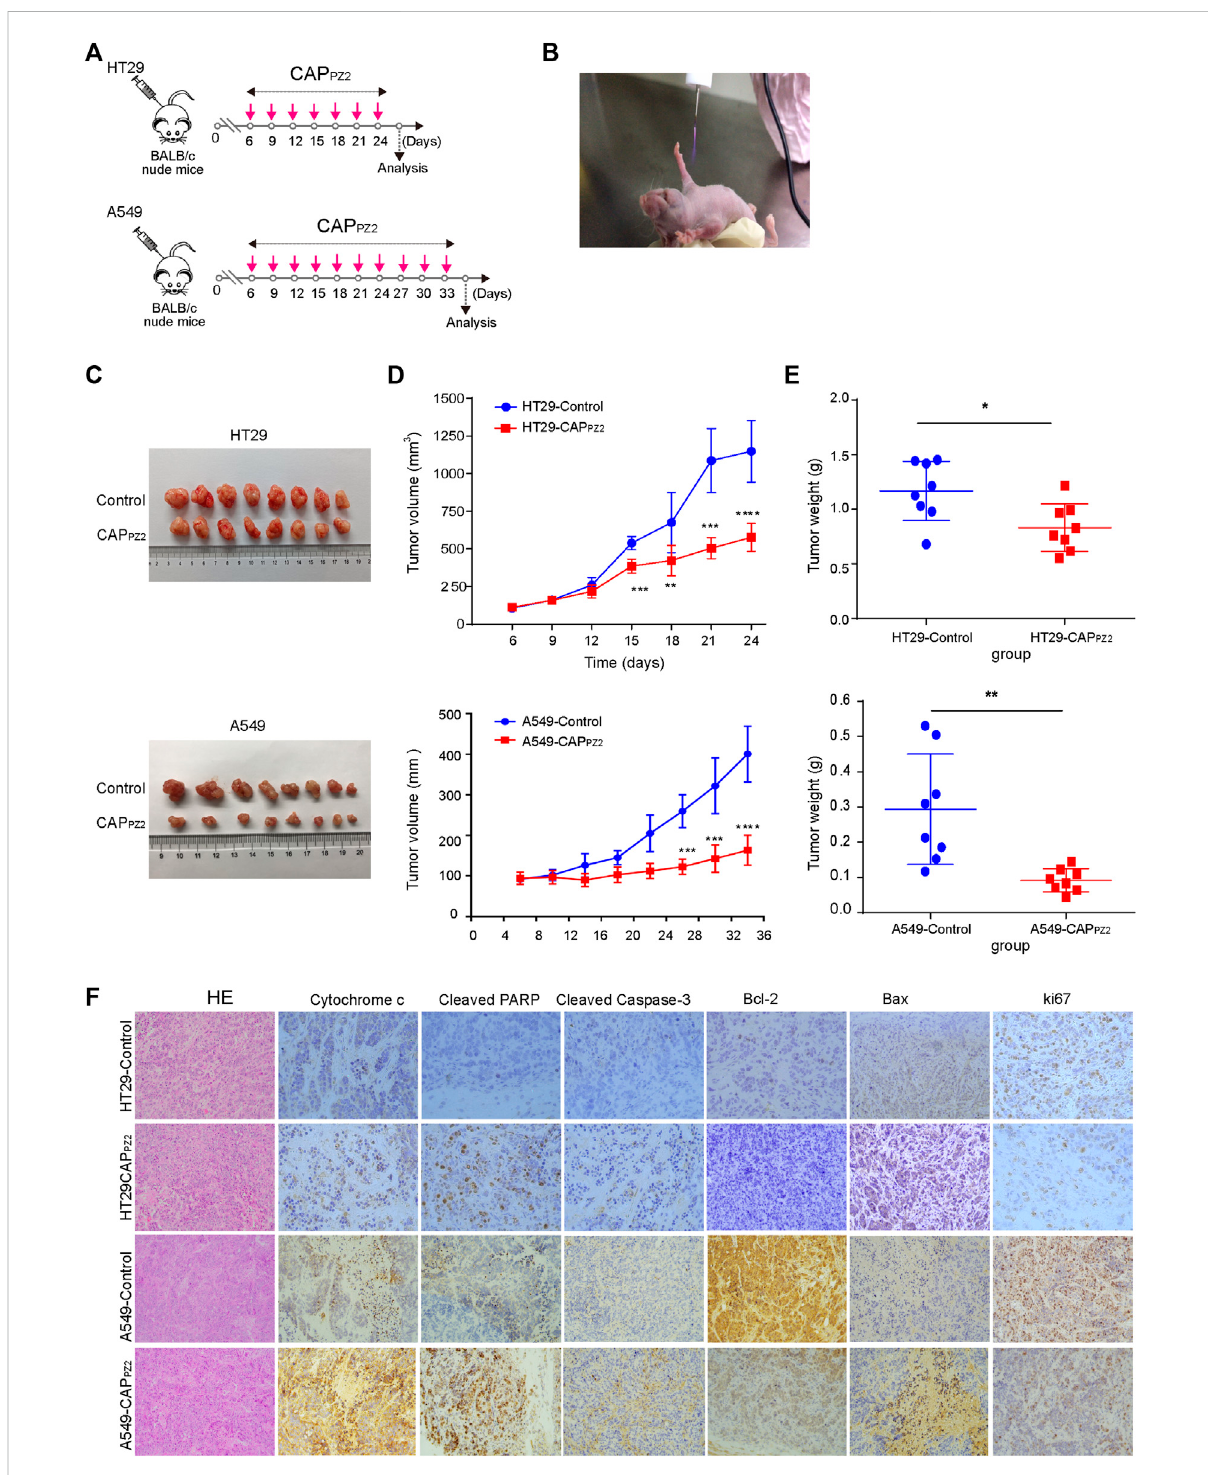
FIGURE 8 in vivo CAP In vivo CAP PZ2 treatment of mouse xenograft tumors. (A) Flowchart of PZ2 therapy regimen. (B) Photograph of an operating Piezobrush ® PZ2 CAP device irradiating tumors on a nude mouse bearing the HT29 or A549 cells. (C) Pathological specimens of resected in situ tumors with and without CAP PZ2 treatment. (D) Tumor growth curves of mice xenografts during the entire course of CAP PZ2 treatment. (E) Tumor weight after the last dose of plasma administration (* p < 0.05, ** p < 0.01, *** p < 0.001, n = 8). (F) Representative histological images characterizing tumours and Immunohistochemical analysis using antibodies against various apoptosis-related proteins. Scale bar = 50 μ